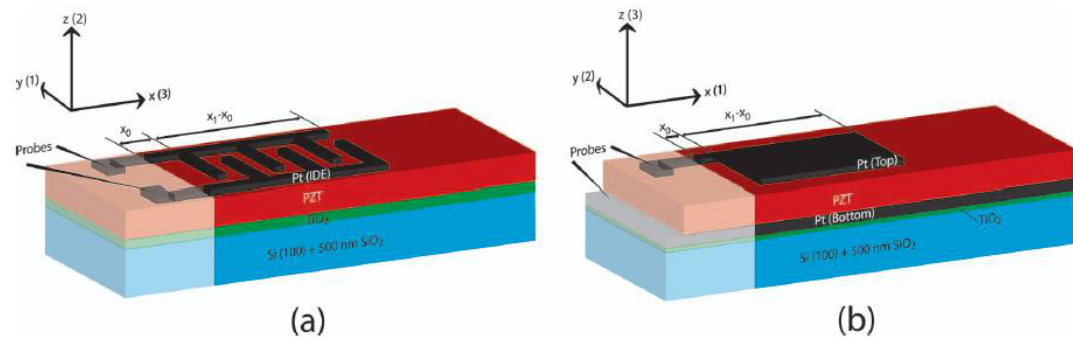
Figure 12. Comparison between ( a ) Interdigitated electrode (IDE) and ( b ) Top and bottom electrode (TBE) configurations ( © 2012 IEEE. Reprinted with permission from